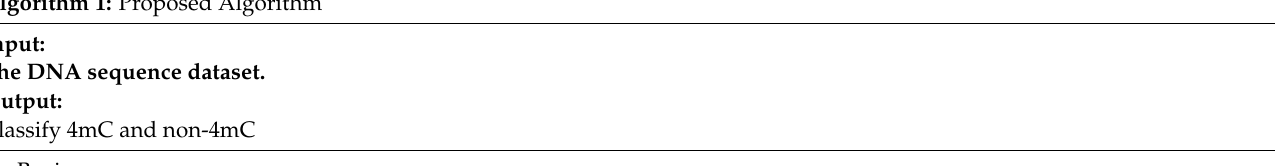
Algorithm 1: Proposed